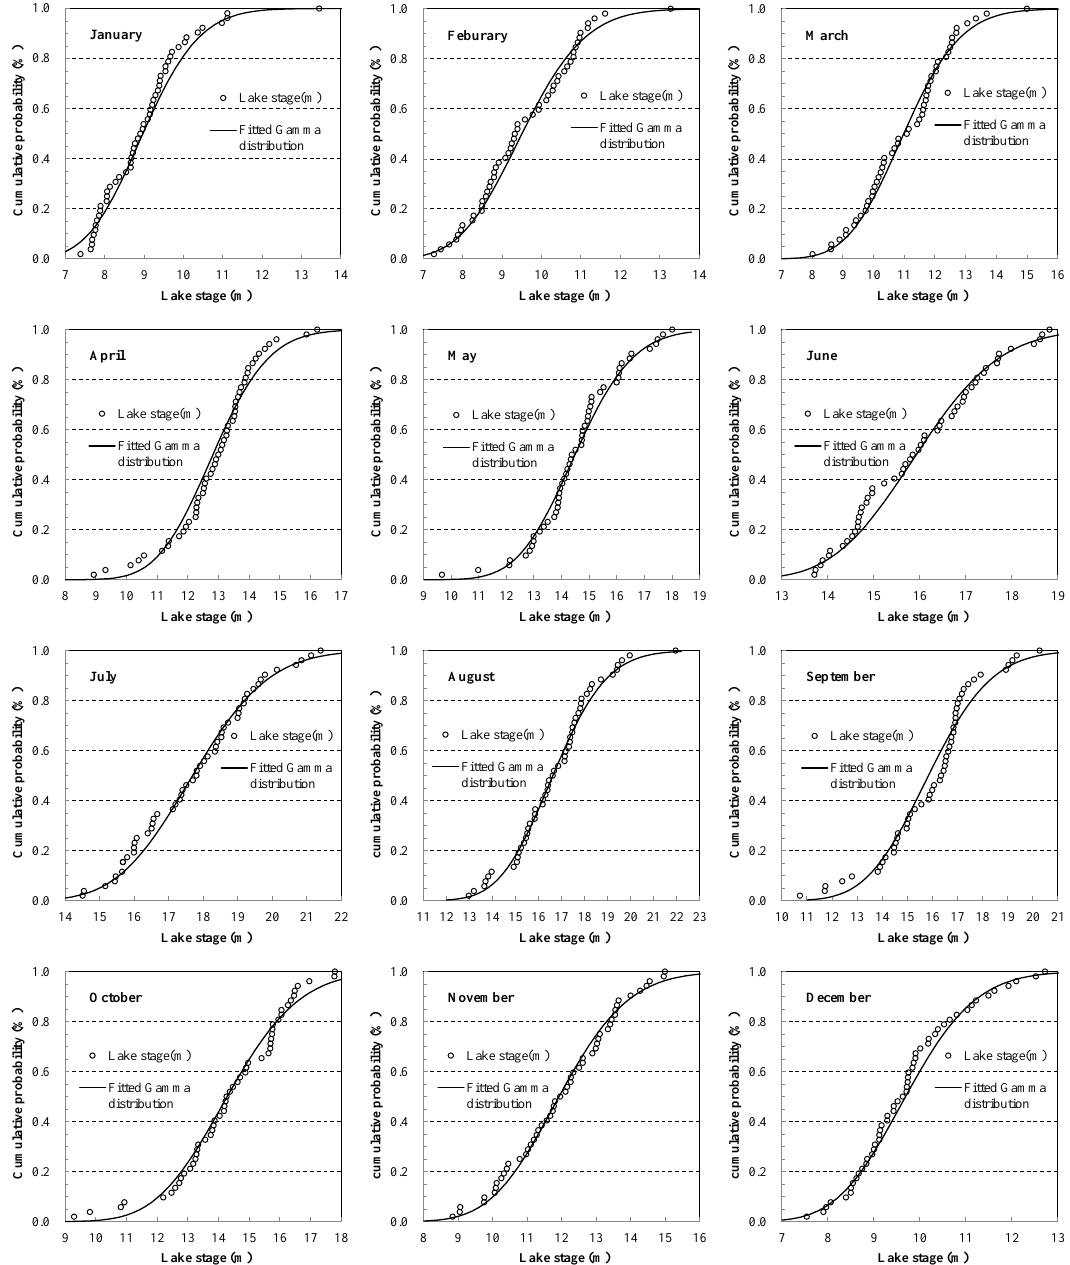
Figure 2. Statistical distribution of monthly average lake stages with a fitted gamma distribution for each calendar month at Xingzi of Poyang Lake in